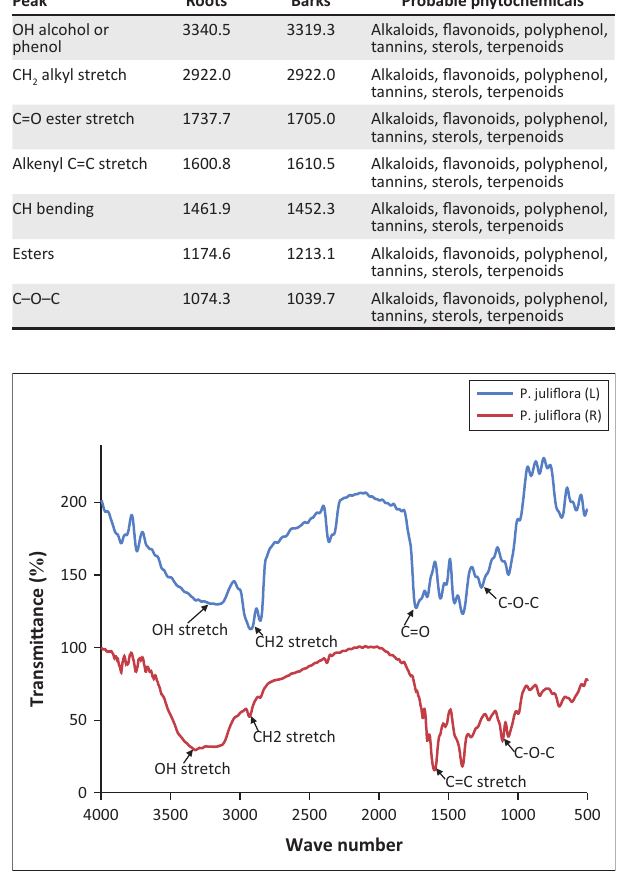
FIGURE 2: Fourier transform infrared spectra of methanolic roots (R) and leaves (L) extracts of Prosopis juliflora.